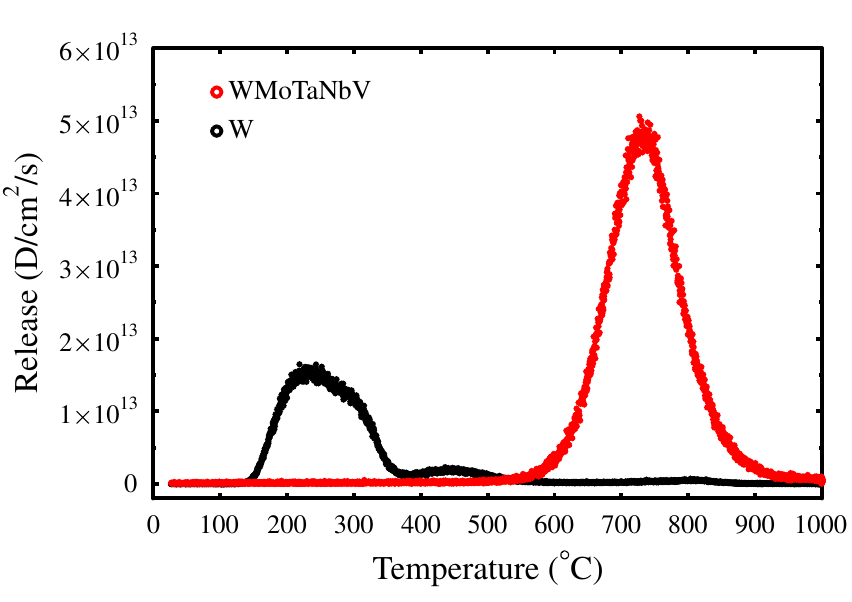
Figure 2. Thermal release D signals from WMoTaNbV and W with 10 ◦ C/min heating rate.